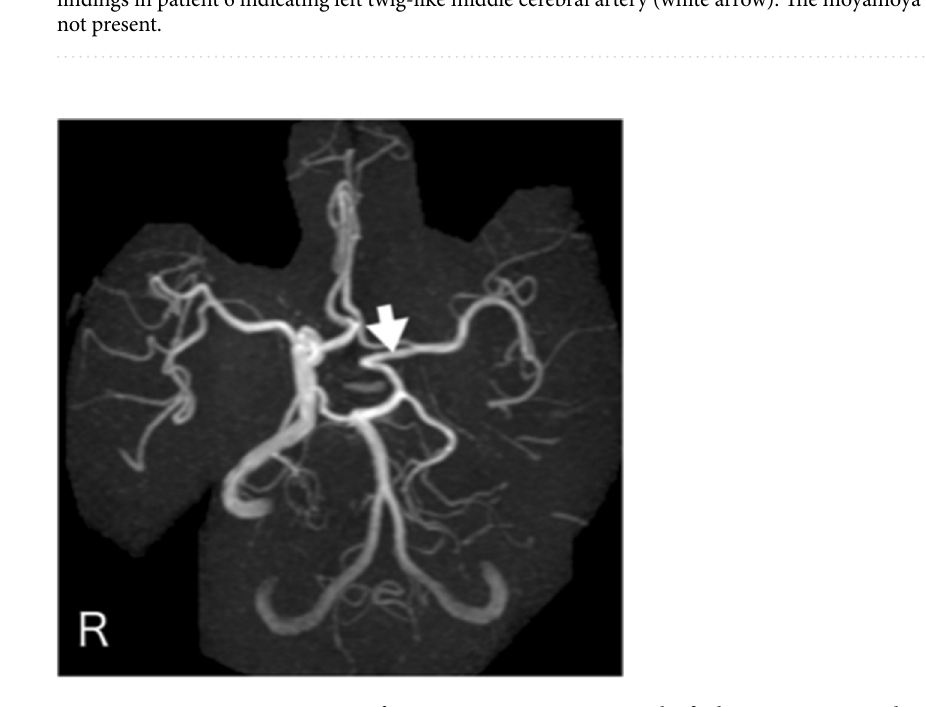
Figure 7. Anterior posterior view of magnetic resonance angiography findings in patient 7 indicating aplasia of the left internal carotid artery (white